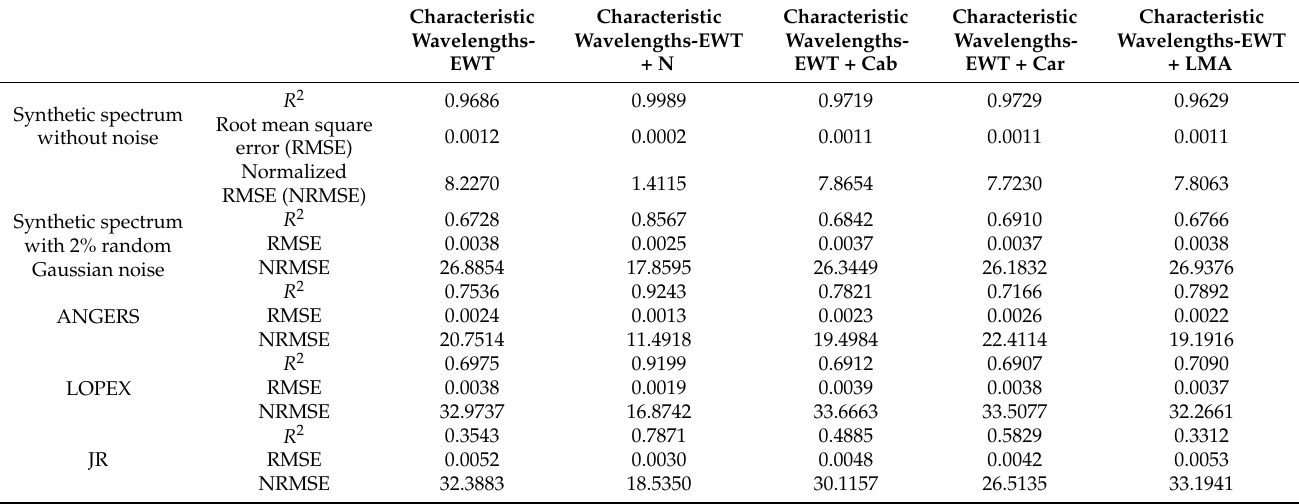
Table 4. Performance of combined different characteristic wavelengths for EWT estimation by using Gaussian process regression